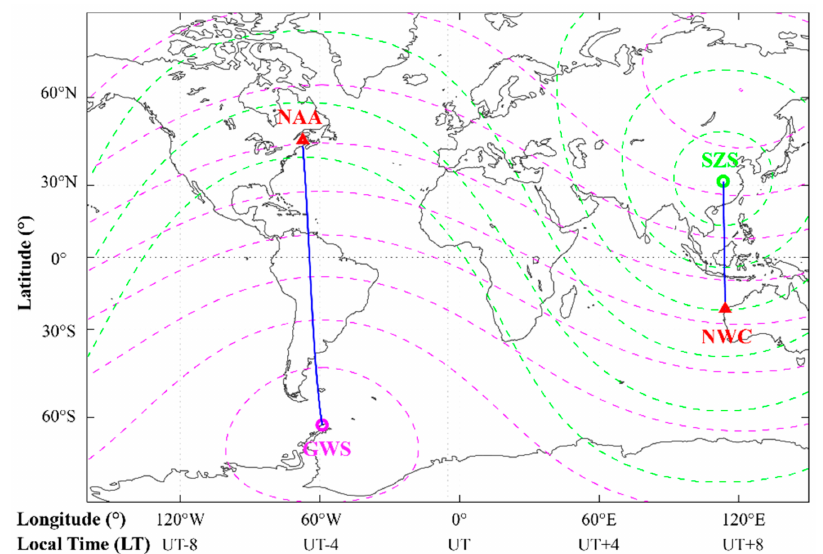
Figure 1. The propagation paths of the NAA signal to the GWS and the NWC signal to the SZS. The red triangles mark the transmitters, and the pink and green circles mark the receiving stations. The propagation path is illustrated using the blue line between the transmitter and receiving station. The pink dashed lines are the auxiliary line centered at GWS and separated by 2000 km, and the green dashed lines are the auxiliary line centered at SZS and separated by 2000